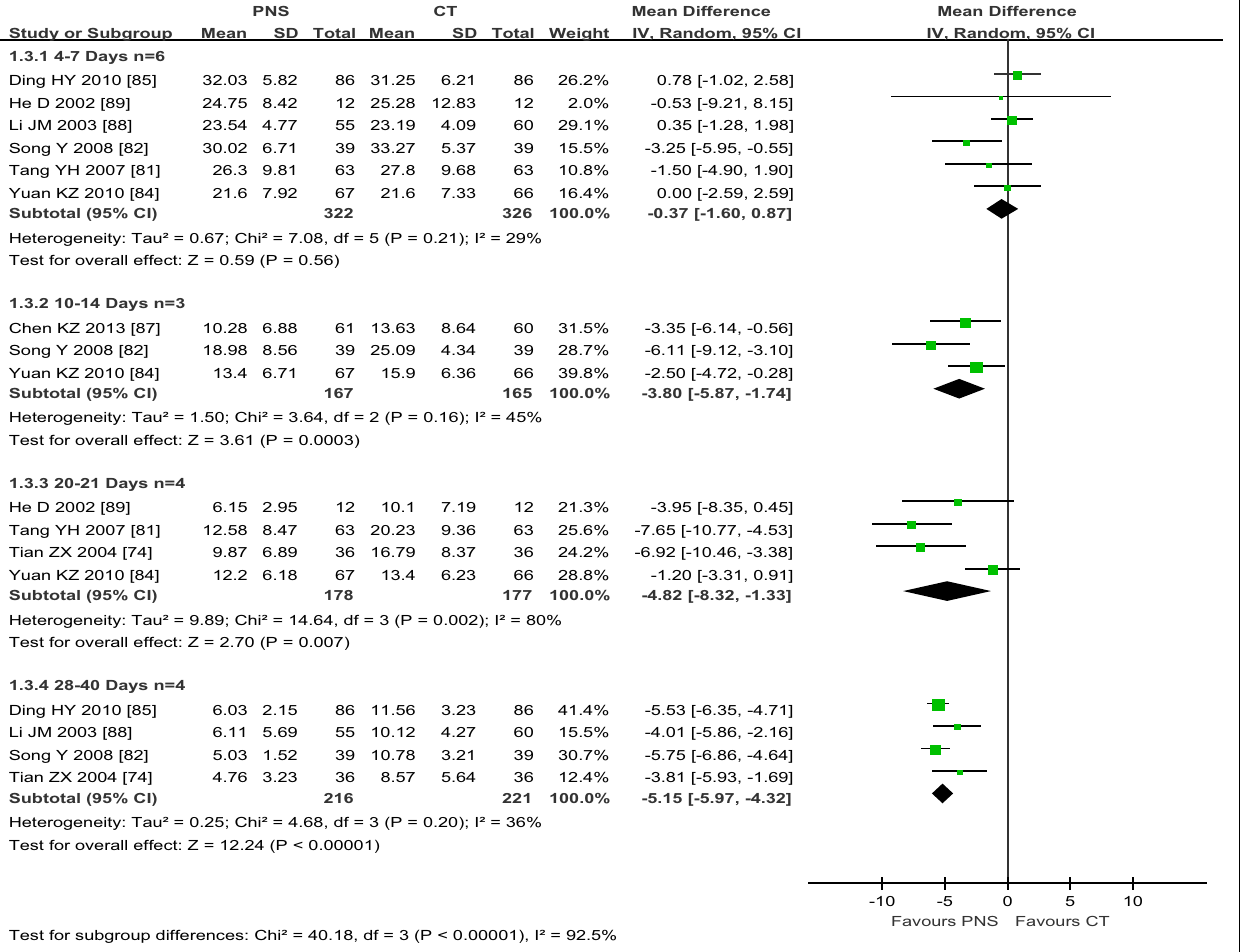
groups; (3) the subgroup of 4 trials with 20–21days of PNS treatment (He D,TangYH,Yuan KZ,Tian ZX) and, (4) the subgroup of 3 trials with 28–40days of treatment [40, 78, 108,] (DingYH, Li JM, SongY,Tian ZX) showed significant improvement in IHV in the PNS group than in the CT group ( P <0.00001, each) . PNS, Panax notoginseng saponin; CT, Current treatment.